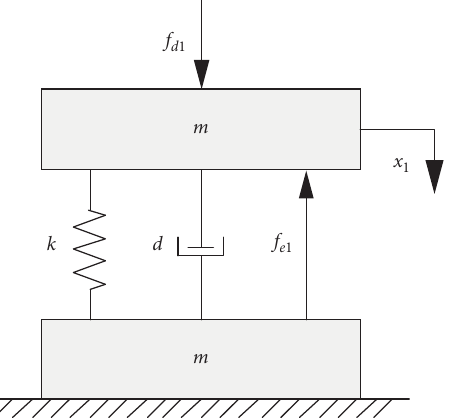
Figure 3: The model of an electromagnetic vibration isolation